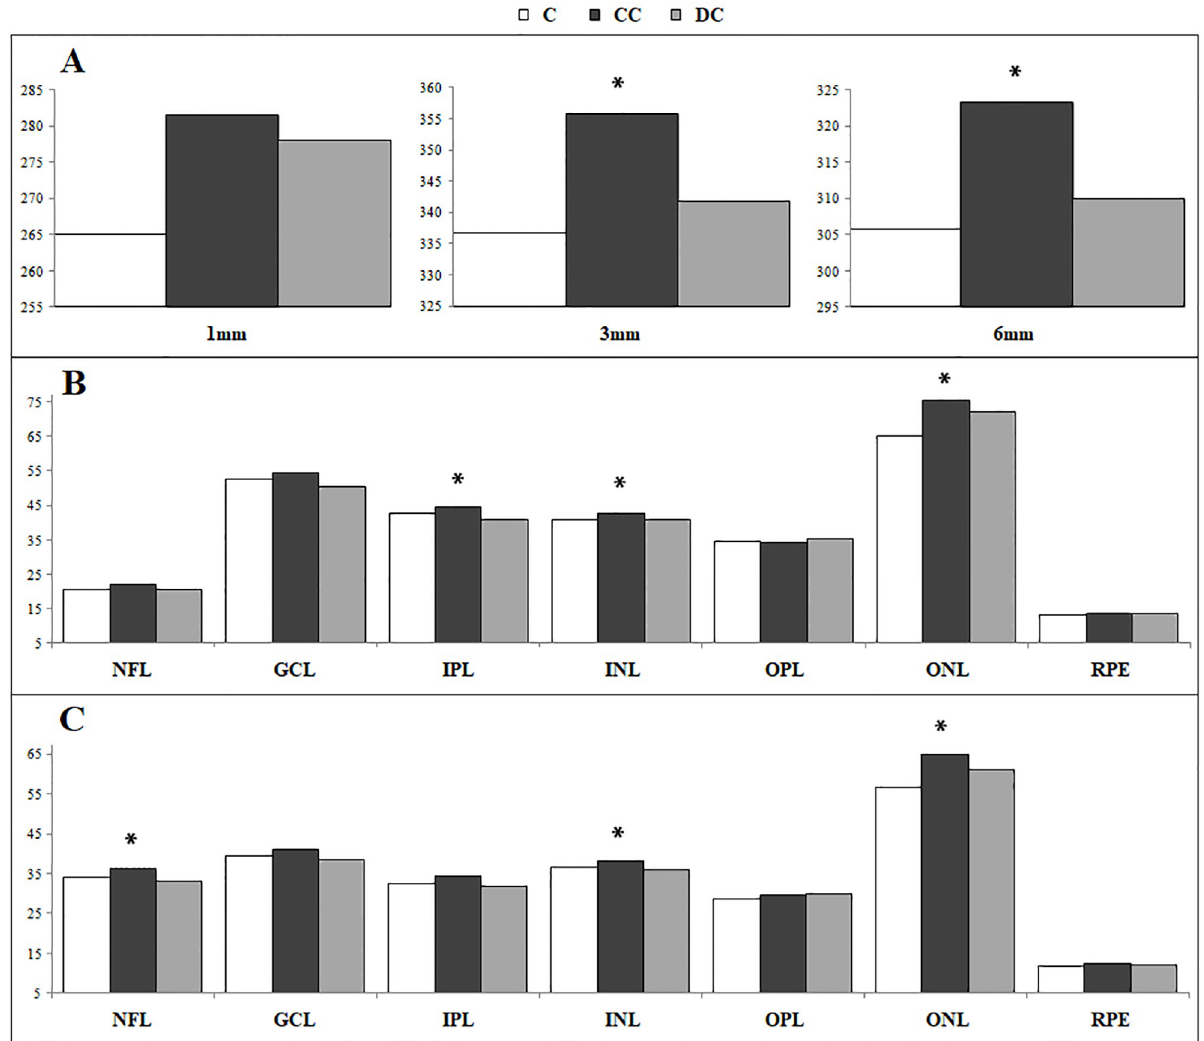
Fig 3. Representative distribution of total retinal thickness (micron). Retinal thickness in control (C), congenital cataract (CC) and development cataract (DC) groups whithin 1, 3 and 6 mm of eccentricity (A); thickness of nerve fibers layer [NFL], ganglion cells layer [GCL], inner plexiform layer [IPL], inner nuclear layer [INL]. outer plexiform layer [OPL], outer nuclear layer [ONL], retinal pigment epithelium [RPE], at 3 (B) and 6 mm (C) of eccentricity. � statistically